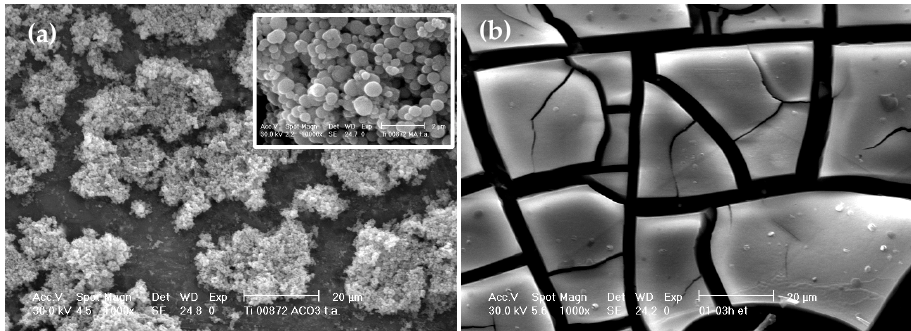
Figure 12. SEM micrographs of un-peptized sample ( a ) and of the same product peptized for 3 h with 0.1 M HNO 3 ( b ).